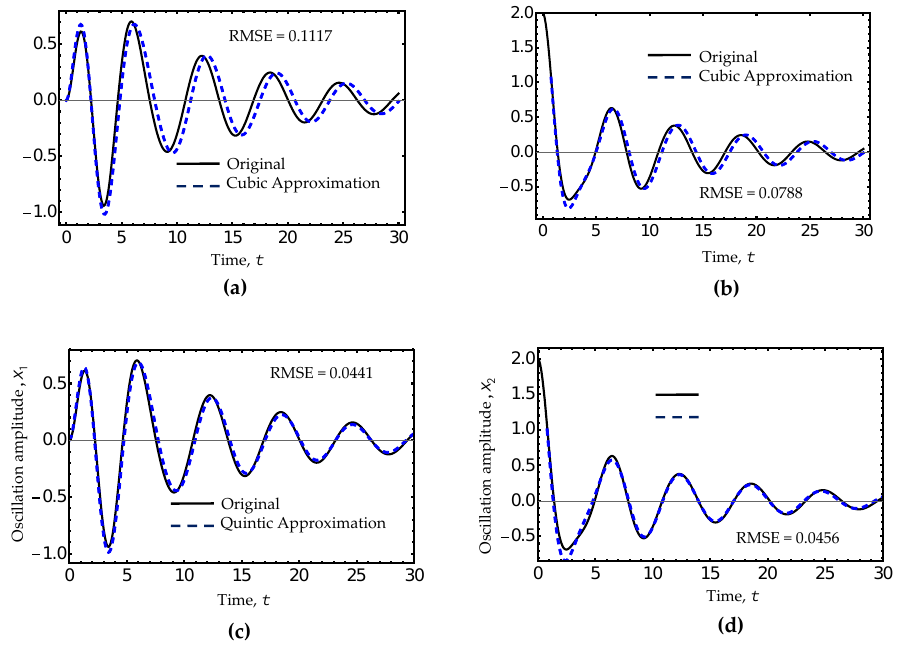
Figure 16. Time-amplitude response curves computed from the numerical integration solutions of Equations (53) and (54). Cubic approximation: ( a ) x 1 vs t , ( b ) x 2 vs t . Quintic approximation: ( c ) x 1 vs t , ( d ) x 2 vs t . The parameter values used to obtain these plots were 𝑚 1 = 𝑚 2 = 1 , 𝑘 = 1 , 𝜀 = 0.5 with 𝑐 = 0.3 , with initial conditions given by (𝑥 1 ,𝑥 2 ,𝑥̇ 1 , 𝑥̇ 2 ) = (0, 0, 2, 0) , 𝑎 1 = 1.055 , 𝑎 2 = 0.1375 , 𝑎 3 = 0.0109 , 𝑏 1 = 2.9995 , 𝑏 2 = 0.1228 , 𝑏 3 = 0.0008 , 𝜇 1 = 0.0807 , 𝜇 2 = −0.0206 , 𝜇 3 = 0.0066 , 𝜇 4 = 0.375 , 𝜇 5 = 0 , 𝜇 6 = 0 , with fitting parameter values of 𝜂 1 = 1 , 𝜂 2 = 0.3 , 𝑉 1 = 1 , 𝑉 2 = −0.15 , 𝜂 11 = −0.01 , 𝜂 22 = 1 , 𝑉 11 = 0 , 𝑉 22 = 1, and weighted mean square error values of U 1 = −2.16 × 10 −5 , U 2 = 0. Here, the black, solid lines describe the numerical integration solutions of Equation (30), while the blue, dashed lines represent the numerical solutions obtained from the nonlinear equations of motion, (53) and (54).